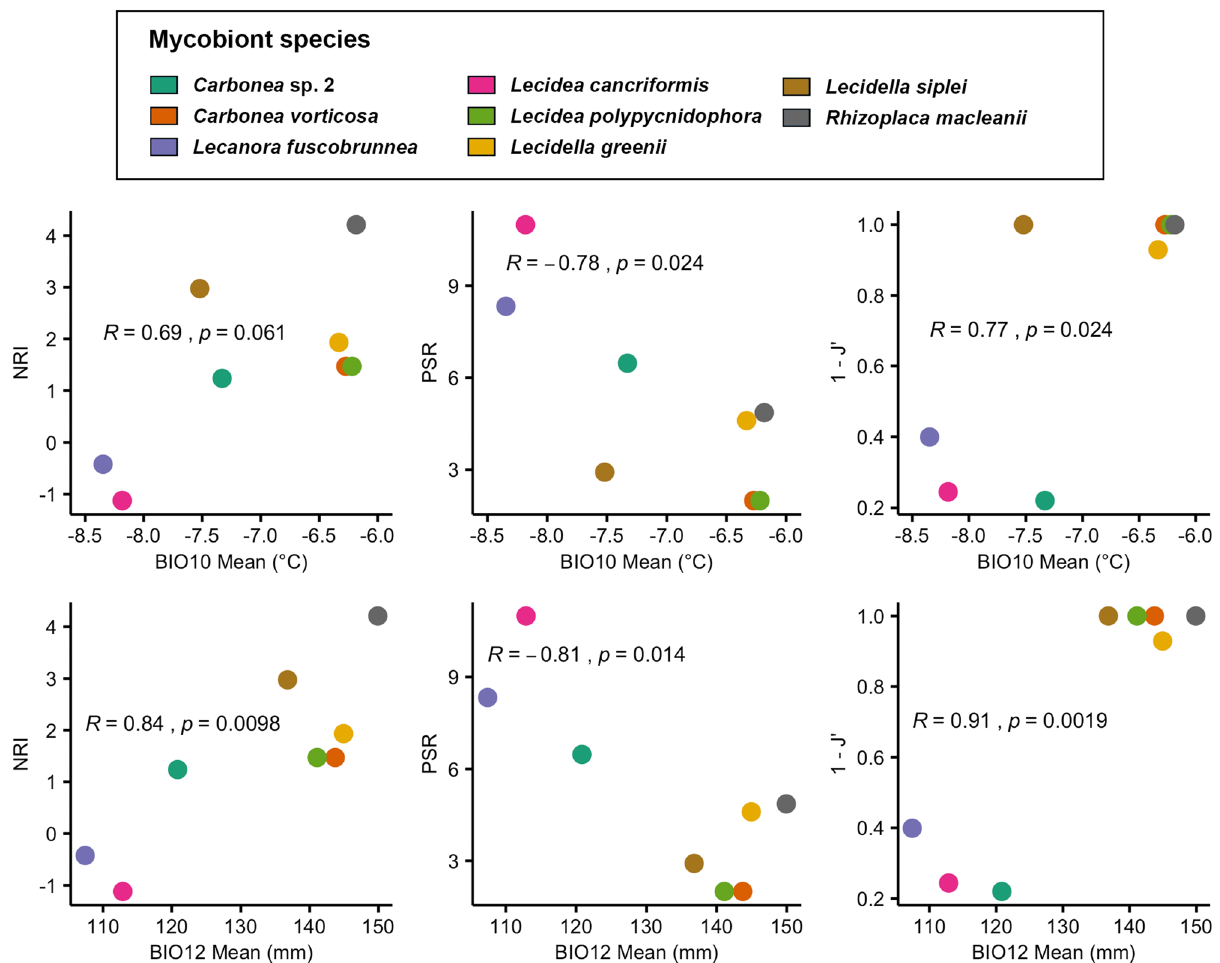
Figure 4. Correlation plots. Specificity indices NRI (net relatedness index), PSR (phylogenetic species richness and 1 – J ′ (Pielou evenness index) against mean values of BIO10 (mean temperature of warmest quarter) and BIO12 (annual precipitation) for mycobiont species with n ≥ 10.